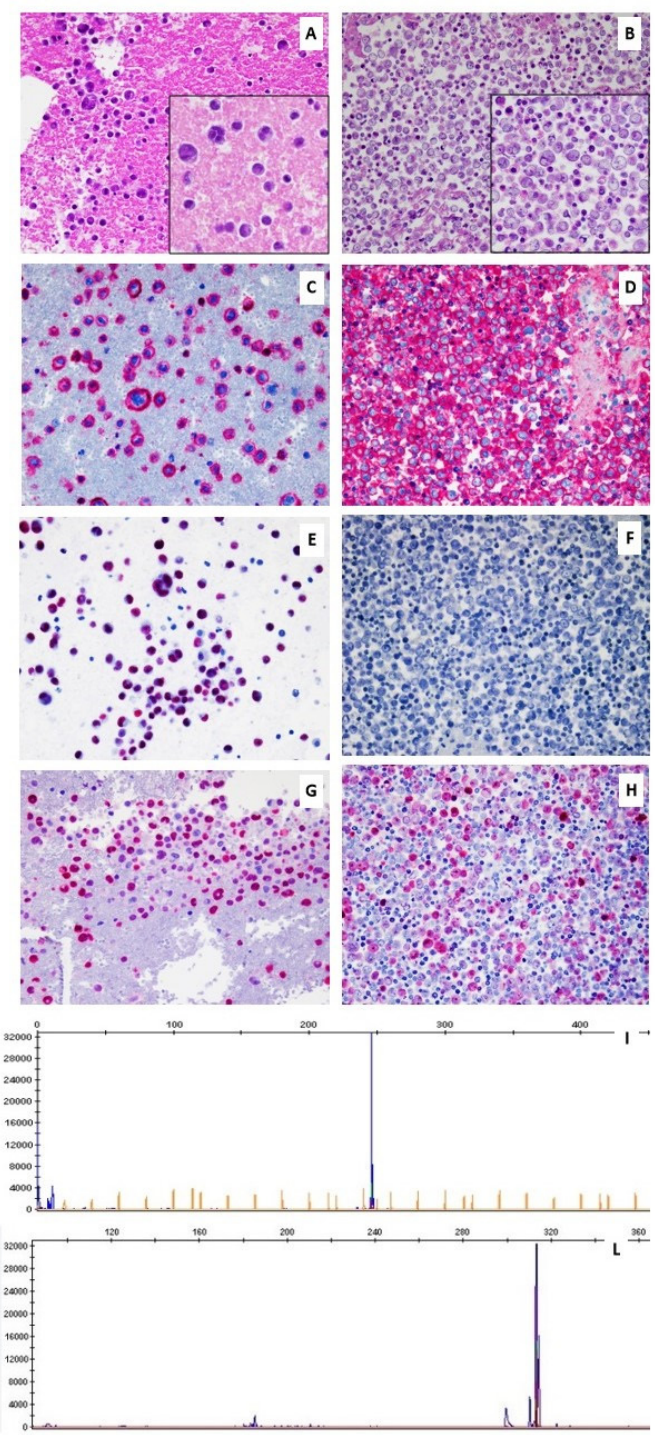
Figure 1. Histopathological features and IGH rearrangement of the two cases of LBCL-like effusion-based lymphoma (EBL) diagnosed in dasatinib-related pleural effusion. Case 1 shows the hematic background including immunoblastic cells ( A ), positive for CD20 ( C ), EBV/EBER ( E ), and with high Ki67 proliferation index ( G ). IGH rearrangement is clonal, as indicated by a monoclonal peak in FR3 region ( I ). Case 2 shows sheets of large lymphoid cells ( B ), positive for CD20 ( D ), negative for EBV/EBER ( F ), and with high Ki67 proliferation index ( H ). Additionally, in this case, a monoclonal peak in the FR3 region proves the clonal rearrangement of IGH ( L